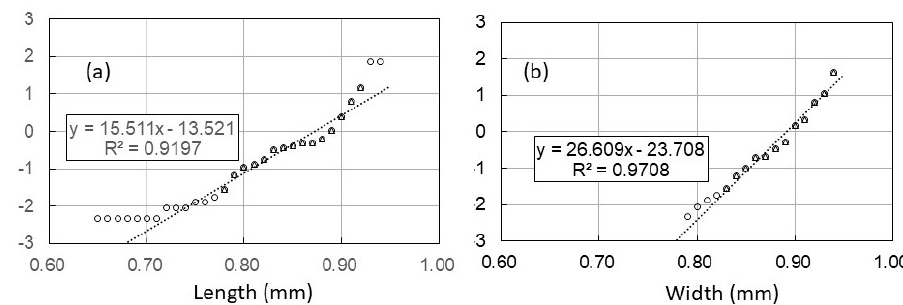
Figure 3. Normalized cumulative frequency distribution (z value on the vertical axis) of the hole size of Specimen #2. Sizes in the ( a ) vertical and ( b ) horizontal directions of the square holes.